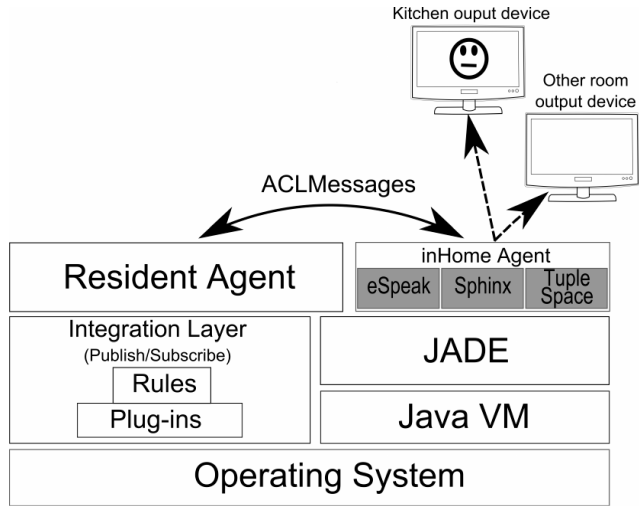
Figure 7. InHome Agent in the software